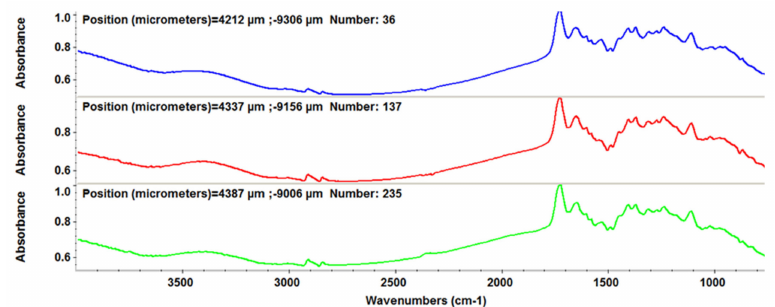
Figure 14. IR spectra recorded for the thin films of Fe 3 O 4 @ β -CD/PTX deposited at F = 400 mJ/cm 2 .